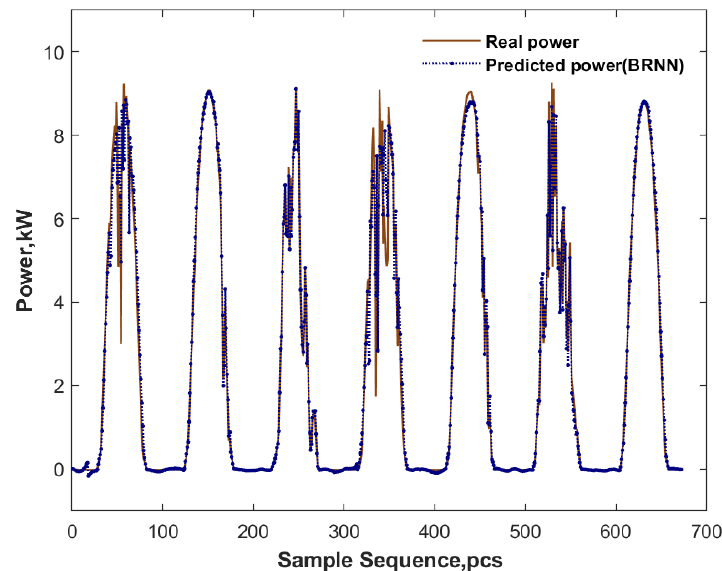
Figure 5. BRNN model prediction results.